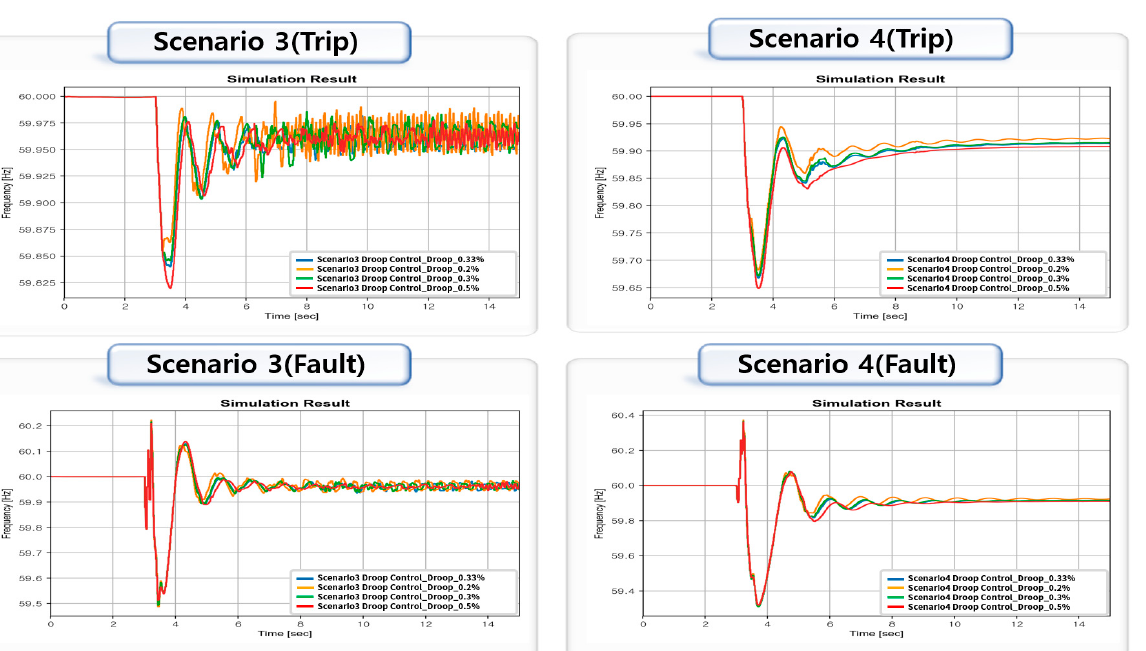
phase short circuits, the lowest frequency decreased. When the UDM model and the ge- neric model were compared, the generic model had a higher lowest frequency, and both models had the same minimum frequency rise.